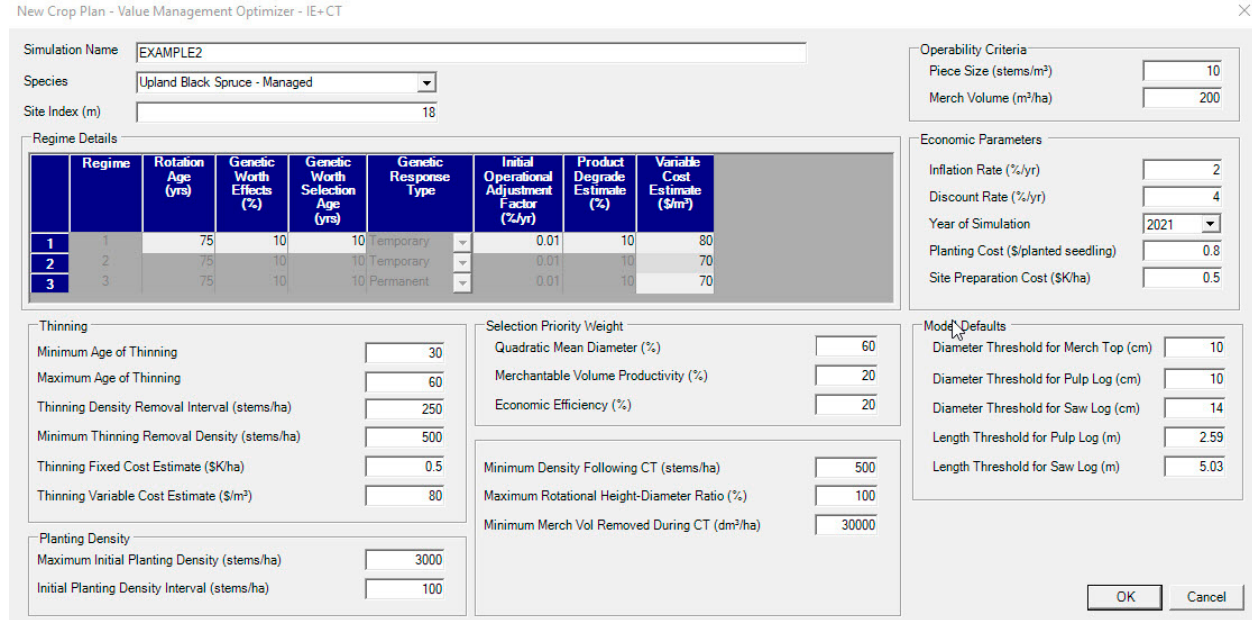
Figure A3. Exemplifying the automated crop plan selection capability of the CP DSS in regard to determining the optimal IE + CT regime within upland black spruce plantations via the deployment of the Value Management Optimizer–IE+CT. Specifically, the input GUI dialog panel inclusive of end-user required input consisting of (1) simulation identifier (name), stand-type selection (species), site index, regime-specific specification of rotation age, genetic worth effect, selection age and response model, operational adjustment and product degrade factors, and variable cost estimates, and overall operability targets, economic assumptions and merchantable specifications applicable across regimes, (2) treatment specifics and constraints inclusive of the maximum IE level and IE simulation searching interval, range of CT treatment ages (events), removal density searching interval (algorithm based), minimum number of trees thinned (operational based), fixed and variable treatment costs, minimum post-thinning residual density, maximum height/diameter ratio tolerable and minimum recoverable merchantable volume from CT required (operational based), and (3) multivariate selection priority weights (size, merchantable volume productivity and economic